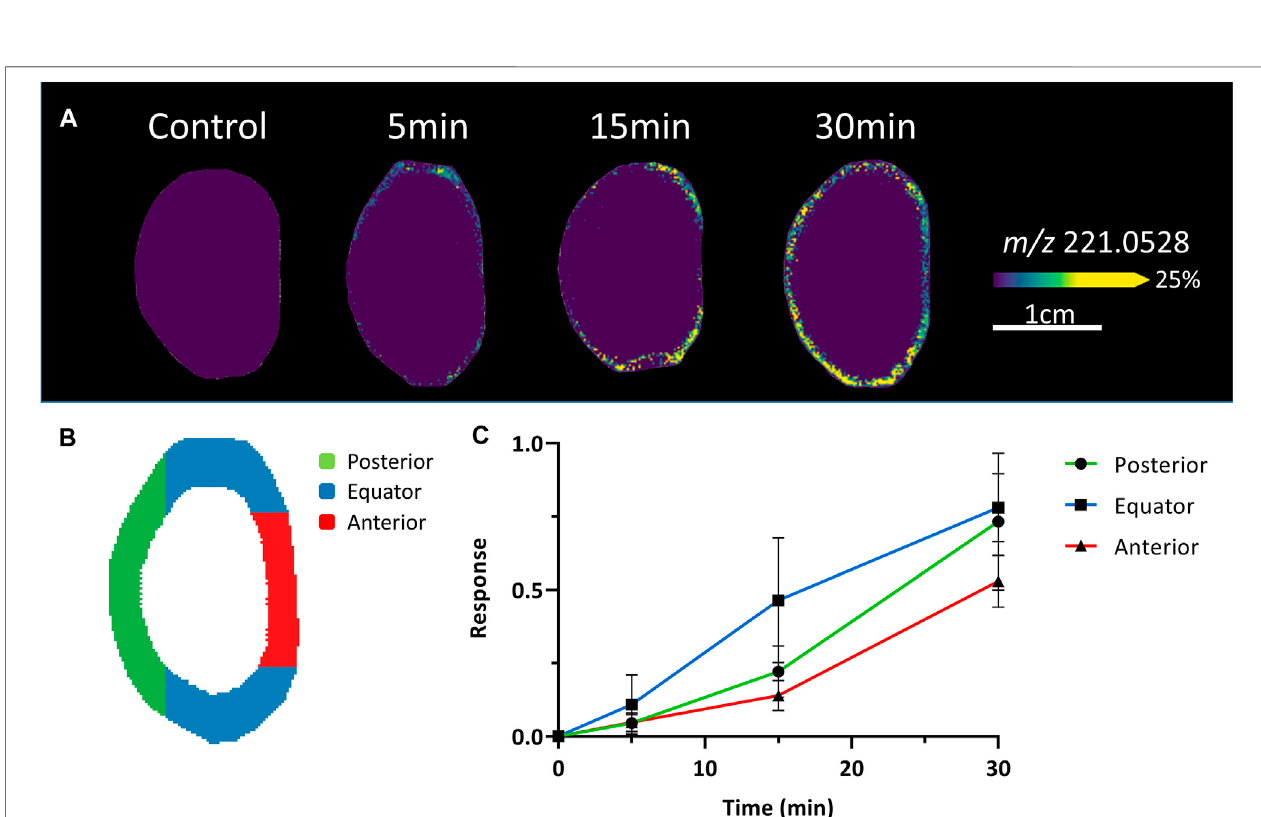
FIGURE3| Comparisonofinitialglucoseuptakeatthesurfaceofthelens. (A) AseriesofMALDIimagesofaxialsectionstakenfrombovinelensesorganculturedin AAH containing 5 mM SIL glucose for 5 – 30 min showing initial differences in SIL glucose ( m/z 221.0528) uptake at the surface of the lens. Control lenses incubated in normoglycaemic AAH containing non-labelled glucose showed no signal at m/z 221.0528. Lenses orientated with anterior surface to the right. (B) Schematic diagram indicating the different regions (anterior = red, equator = blue, posterior = green) of the lens surface from which SIL glucose signals were extracted for relative quanti fi cation and comparison. (C) Intensity plots from the different regions shown in B indicate that the initial uptake of SIL glucose at the surface of the lens occurs predominately in the equatorial region, which contains both equatorial epithelial cells and elongating fi bre cells, relative to the anterior and posterior regions of the lens